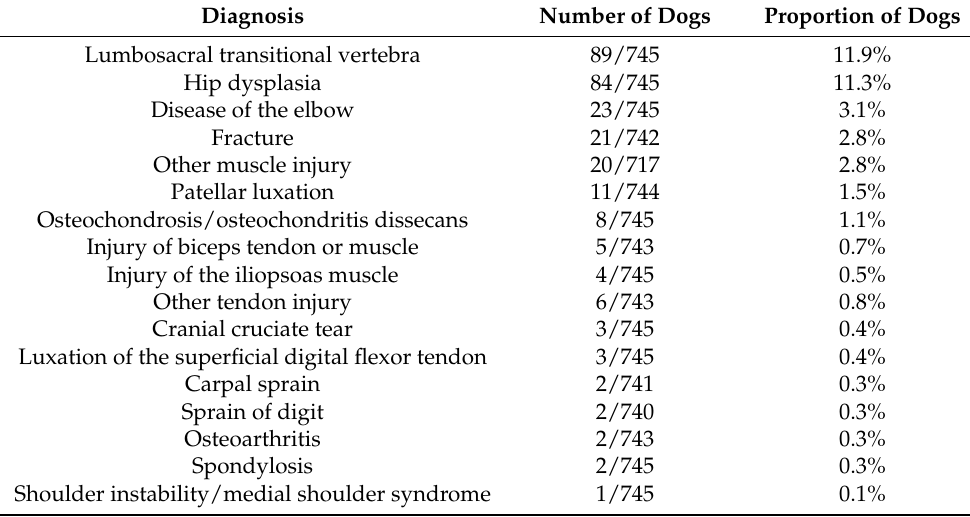
Table 7. Frequency of selected musculoskeletal diagnoses in competition-level agility